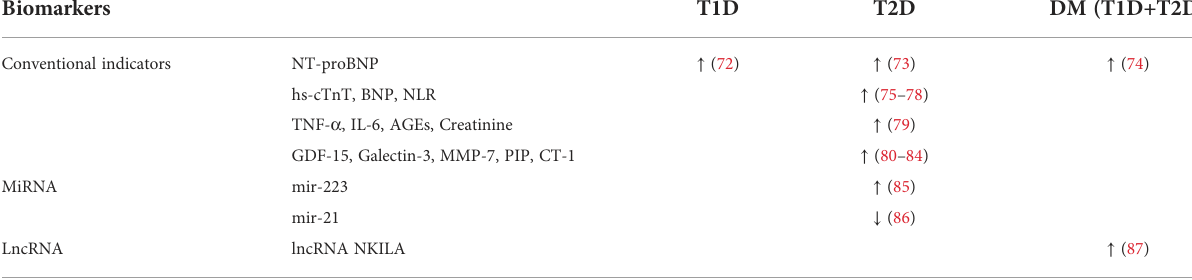
TABLE 1 Main clinical fi ndings of biomarkers for cardiac dysfunction in T1D and T2D patients.